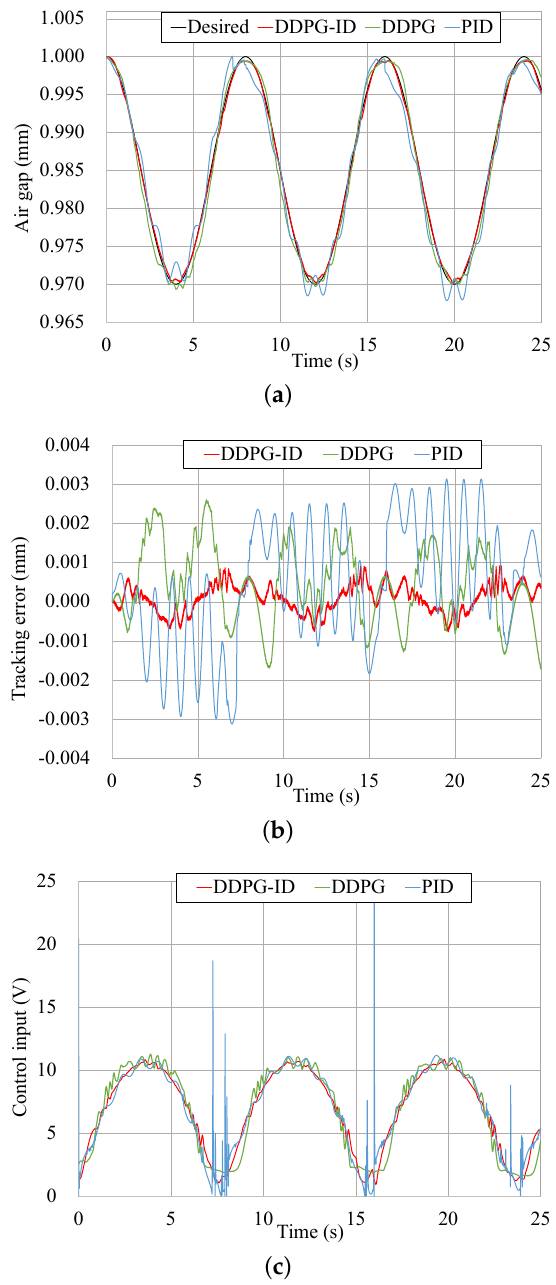
Figure 9. Tracking results comparison of the waved trajectory. ( a ) Tracking results comparison based on three control schemes. ( b ) Tracking error comparison based on three control schemes. ( c ) Control input comparison based on three control